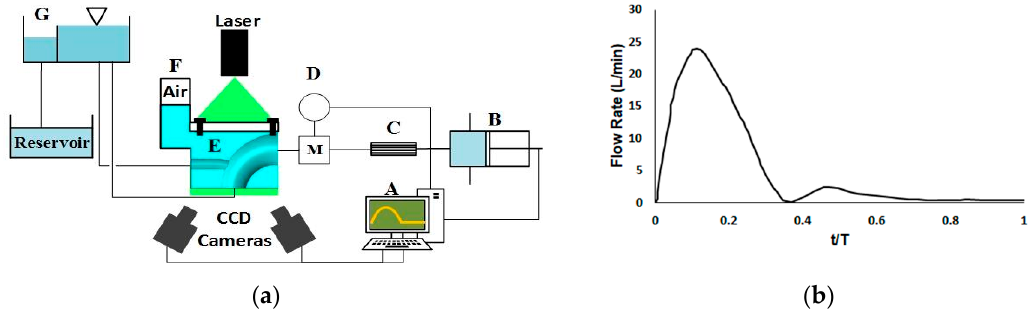
Figure 3. ( a ) schematic diagram of the fluid circuit and particle image velocimetry (PIV) setup; A: data acquisition system, B: piston pump, C: flow straightener, D: electromagnetic flowmeter, E: pressure box, G: header tank with weir; ( b ) physiological flowrate waveform.